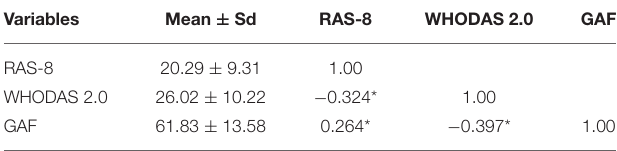
TABLE 1 | Socio-demographic characteristics and association with recovery. TABLE 2 | Clinical characteristics and association with recovery.